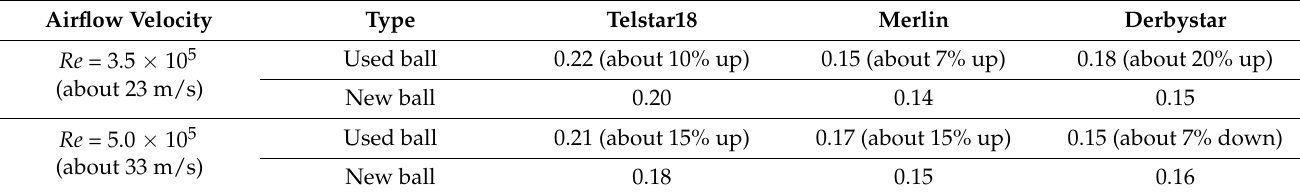
Table 1. C D values of the new and used balls used in this